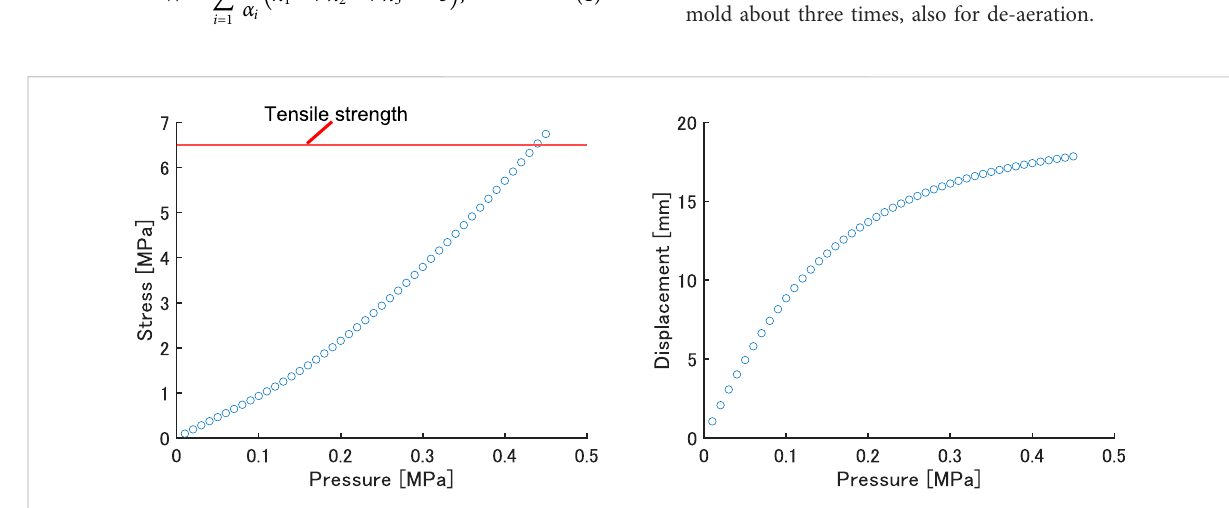
FIGURE 11 Finite-element-method predictions of stress and displacement as functions of applied